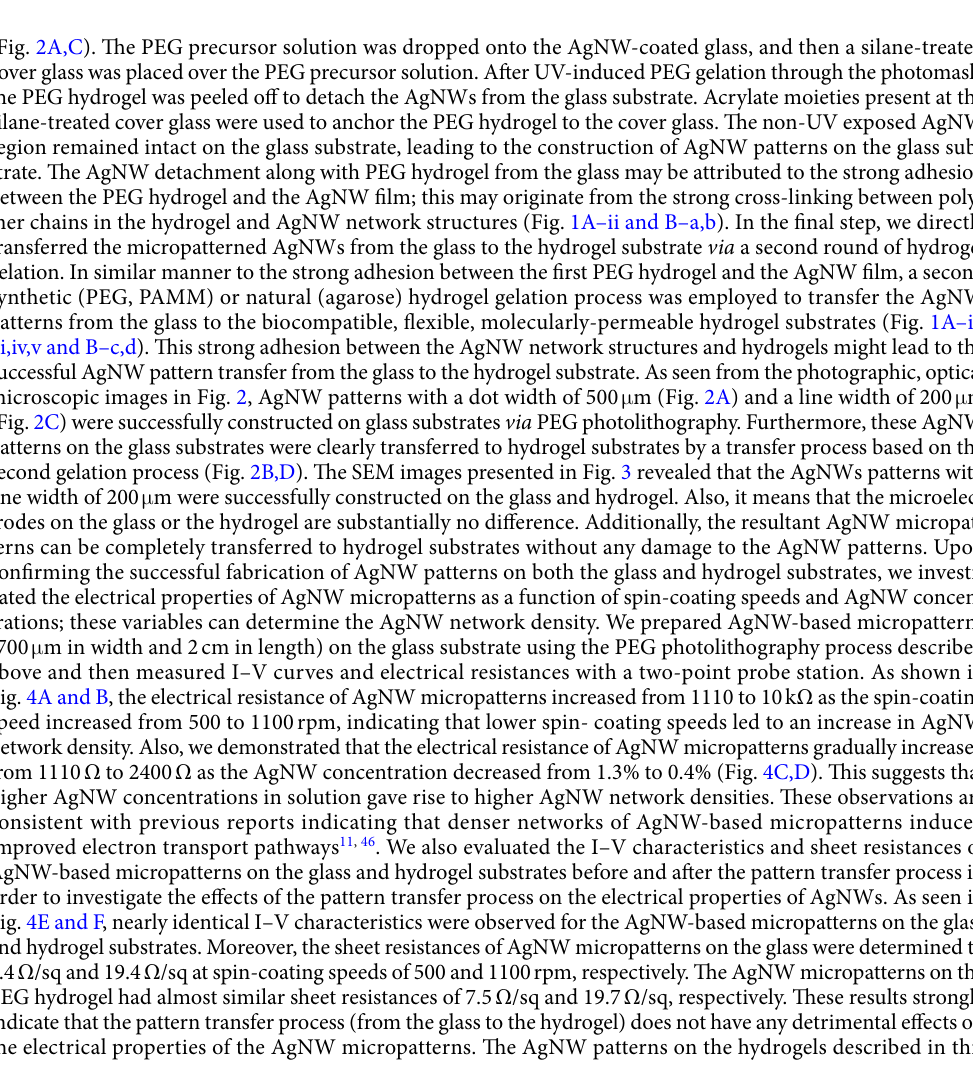
Figure 2. Photographic and optical microscopic images of AgNW-based micropatterns with ( A , B ) dot of 500 μ m diameter and ( C , D ) line of 200 μ m width) on the ( A , C ) glass and ( B , D )